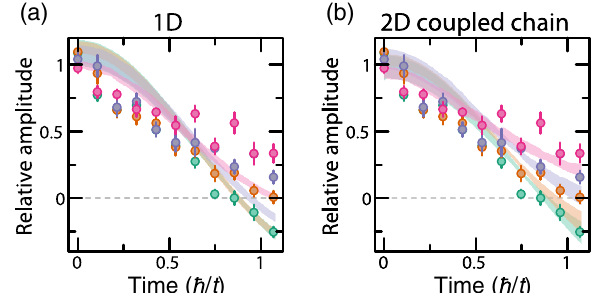
FIG. 6. Role of interchain couplings in slowing down charge- density wave relaxation. Numerical simulations of a t − V model with tunneling t along only one direction and isotropic nearest-neighbor interactions V . (a) Fitted relative sinusoid am- plitude to observed (circles) and calculated quench dynamics of 1 × 21 systems (shaded regions). The colors represent the dif- ferent interaction strengths V=t ¼ ½ 0 ð green Þ ; 0 . 78 ð 7 Þð orange Þ ; 1 . 61 ð 8 Þð purple Þ ; 2 . 9 ð 2 Þð pink Þ(cid:2) explored in the experiment. (b) Same comparison as in (a) but for calculations done on 2 × 11 systems. This plot is Fig. 4(d). Experimental error bars correspond to the standard error of the